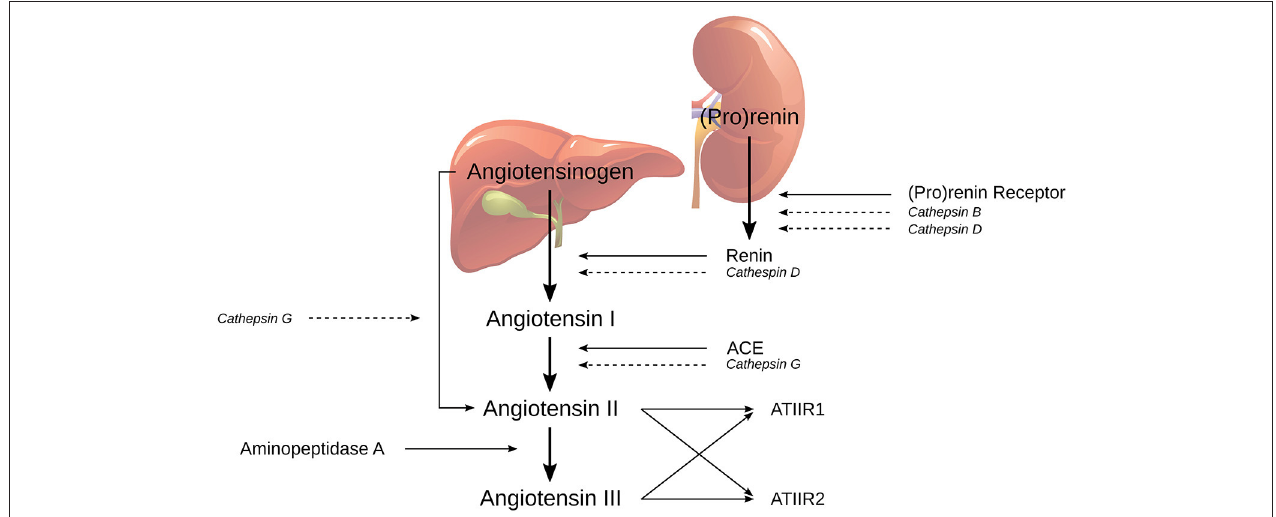
FIGURE 1 | The classical renin-angiotensin system (RAS) and its bypass loops consisting of cathepsins B, D, and G. Classically (pro)renin, from the juxtaglomerular cells in the kidney, is activated by binding to the (pro)renin receptor. Renin coverts angiotensinogen (AGN), produced by the liver, to form angiotensin I (ATI), which is further cleaved to form angiotensin II (ATII), by angiotensin converting enzyme (ACE). Aminopeptidase A then converts ATII to angiotensin III; both of which activate either angiotensin II receptor 1 (ATIIR1) and/or angiotensin II receptor 2 (ATIIR2). Alternately, the RAS may be activated via its bypass loops. Cathepsin B and cathepsin D are renin-activating enzymes. Cathepsin D bears significant homology to renin and is therefore able to independently catalyze the conversion of AGN to form ATI. Cathepsin G may form ATII from either ATI or directly from AGN. Adapted with permission from Integrative Cancer Science and Therapeutics (